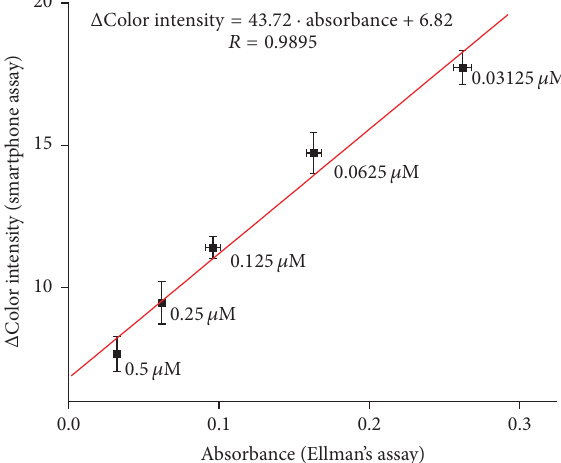
Figure 8: Verifying of galanthamine assay in plasma samples compared to standard galanthamine solution. Error bars represent standard error of the mean for 𝑛 = 3.